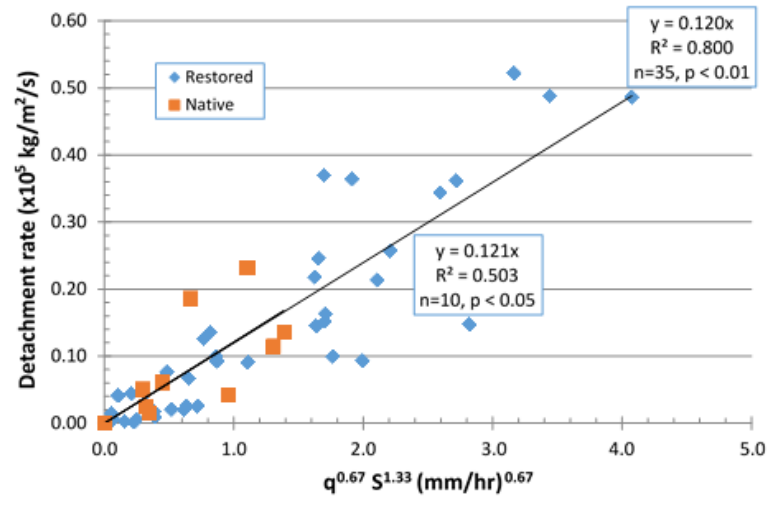
Figure 8. Comparison between and stream power variables for bare and grass-covered volcanic RS plots on the northwest shore of Lake Tahoe.